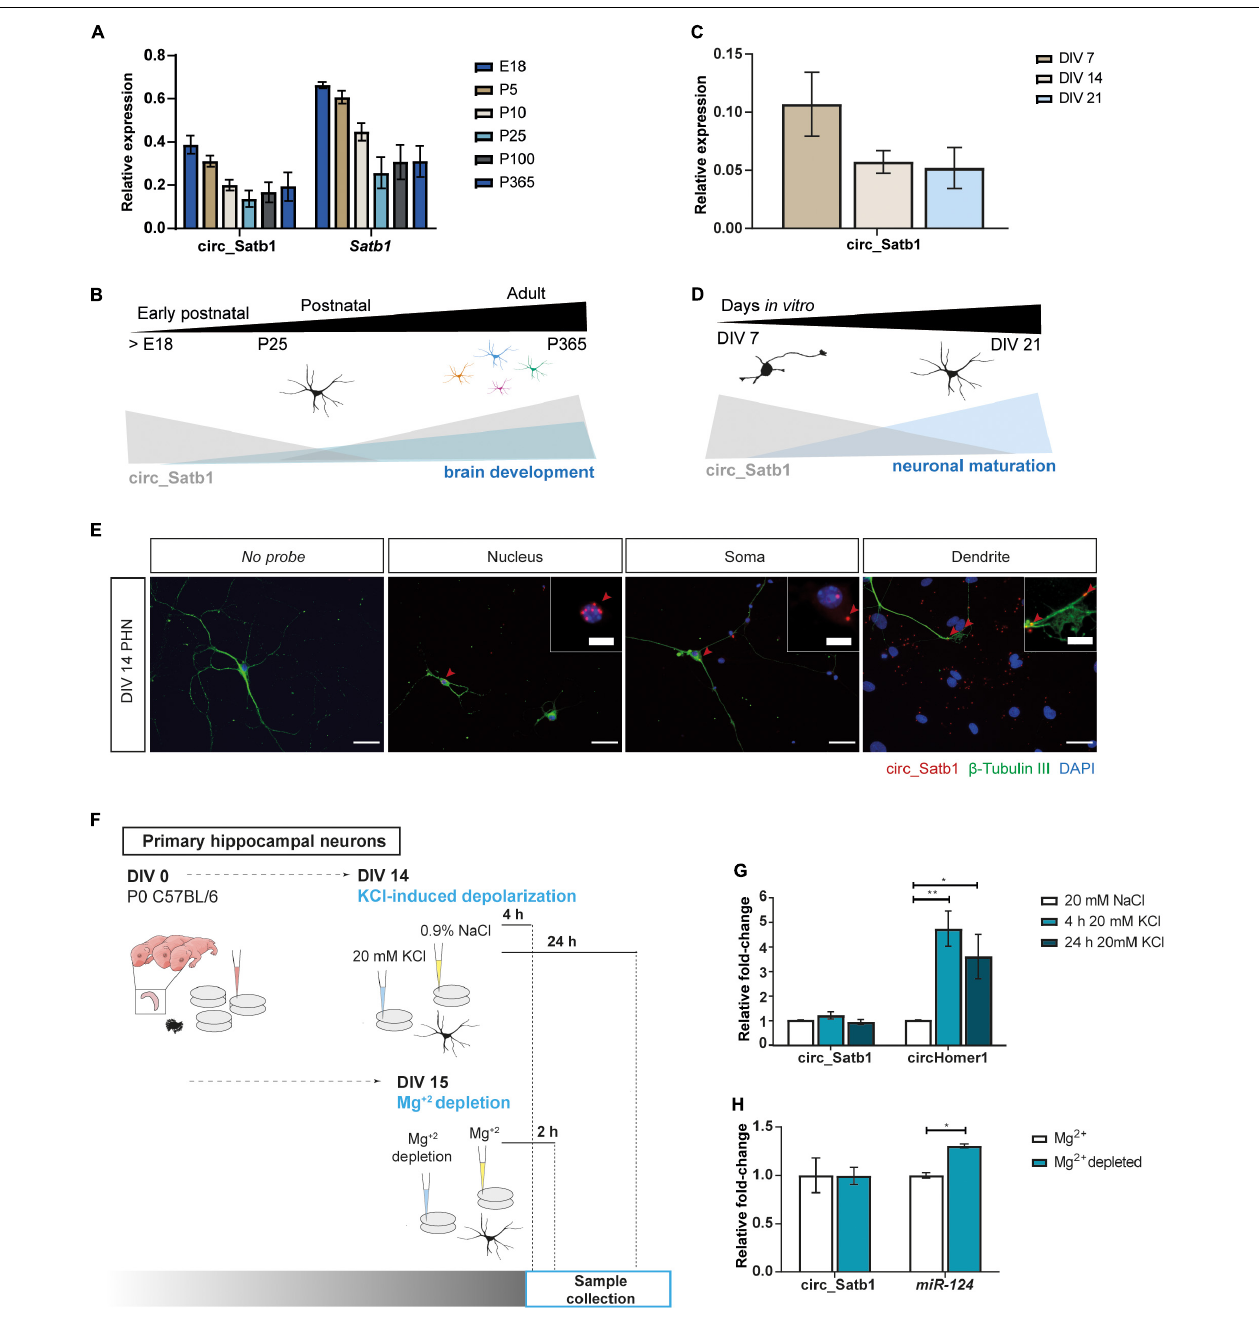
FIGURE 4 | Characterization of neural circ_Satb1 expression. (A) Expression profile of Satb1 /circ_Satb1 in the developing hippocampus, normalized to Pgk. Bar plots show group mean ± SD. N = 3 animals per time point (E, embryonic; P, postnatal). (B) Schematic representation of the circ_Satb1 profile during neuronal maturation. (C) Expression profile of circ_Satb1 in mouse PHN at indicated time points, normalized to Pgk. Bar plots express group mean ± SD. N = 2 independent experiments (DIV, day in vitro ). (D) Schematic representation of the circ_Satb1 profile during postnatal development of the hippocampus. (E) Detection of circ_Satb1 with fluorescent in situ hybridization in PHN (red). Neurons were stained with neuron-specific class III beta-tubulin ( β -Tubulin III) (green) and nuclei with 4,6-diamidino-2-phenylindole (DAPI) (blue). Scale bar: 40 µ m. Red arrows indicate circ_Satb1 relevant subcellular localization signals (nucleus, soma, and dendrites), which are shown at higher magnification in upper right panel images. Scale bar: 10 µ m. (F) Schematic overview of the functional assays performed in PHN. (G) Circ_Satb1 fold-change upon KCl treatment of PHN, normalized to Gapdh . Bar plots represent fold-changes relative to control condition (NaCl) ± SEM. CircHomer1 was used as a positive control (You et al., 2015) (** p = 0.0078, * p = 0.0348). Ordinary one-way ANOVA; n = 3 independent experiments (NaCl, saline; KCl, potassium chloride; Gapdh , Glyceraldehyde 3-phosphate dehydrogenase ). (H) Circ_Satb1 and miR-124 fold-change upon extracellular Mg + 2 depletion of PHN neurons, normalized to Gapdh or 5s rRNA. Bar plots represent fold-changes relative to control condition (Mg + 2 ) ± SEM. MiR-124 was used as a positive control (* p = 0.0020), as a highly enriched miRNA in neuron-derived exosomes (Jiang et al., 2020). Multiple unpaired t -tests with Holm-Šídák method for multiple comparisons; n = 3 independent experiments (Mg + 2 ,